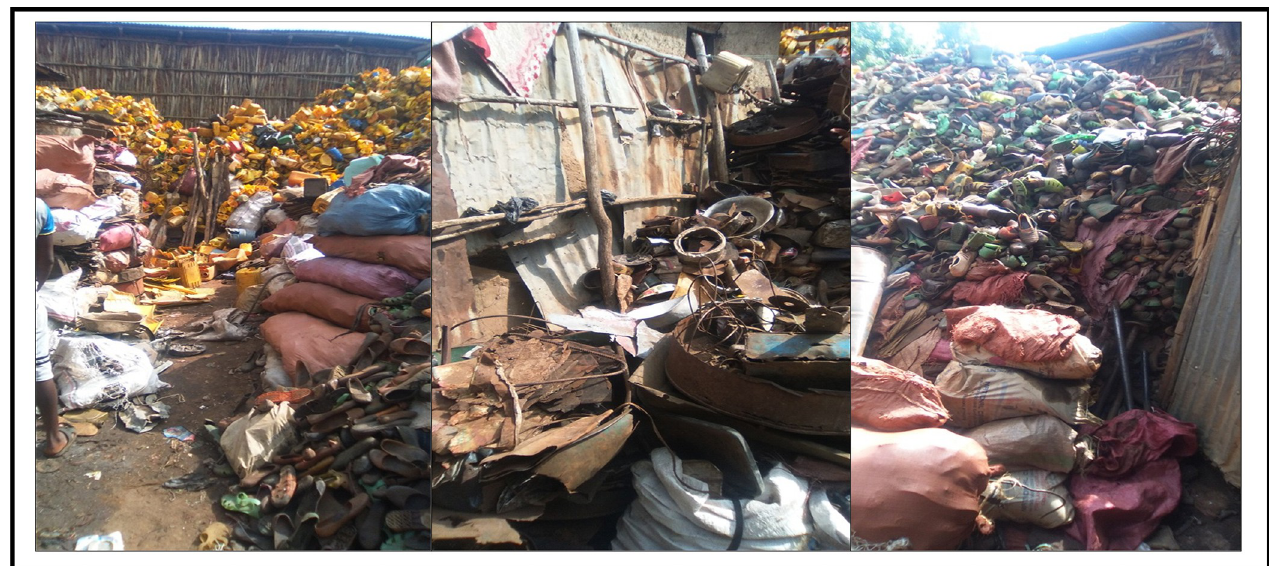
Fig 1. Collection of solid wastes by Korale and Lewache for recycling (Source: Field observation by researcher). Left to right: plastics, beverage cans, glass and bottles; metals, corrugated iron sheets; and textiles and shoes.